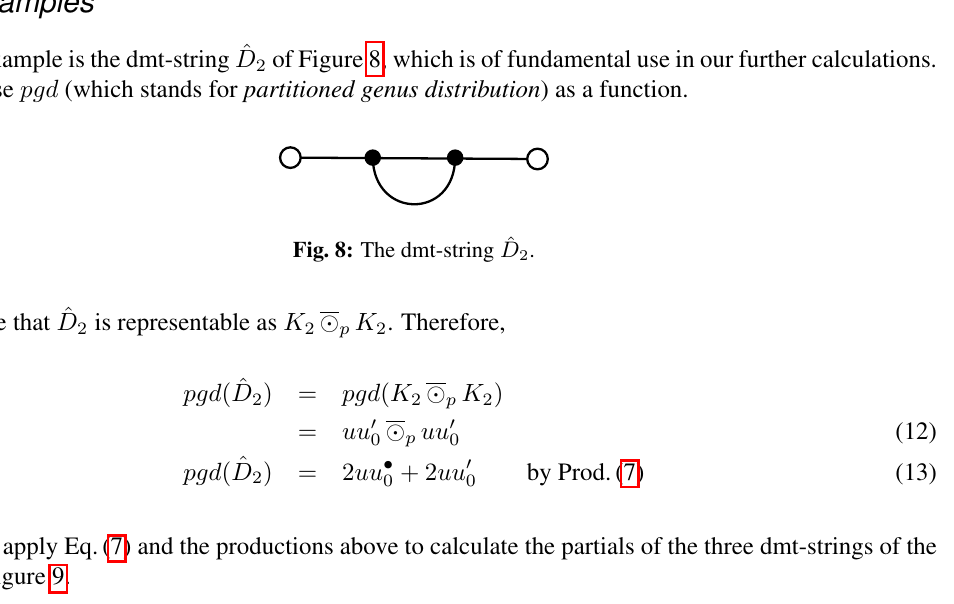
Fig. 7: Production: uu (cid:48) i (cid:12) p uu (cid:48) j −→ 2 uu (cid:48) i + j + 2 uu • i + j .